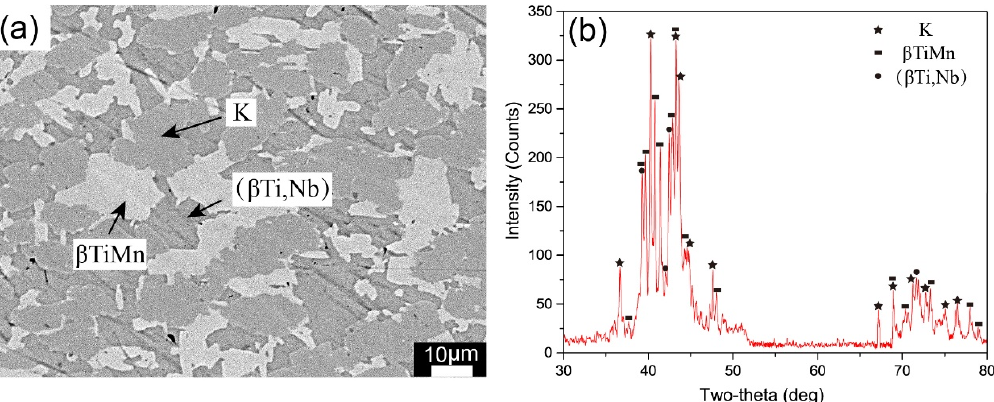
Figure 10. Alloy A8 annealed at 1173K for 90 days: ( a ) back-scattered electron (BSE) images, ( b ) XRD patterns.